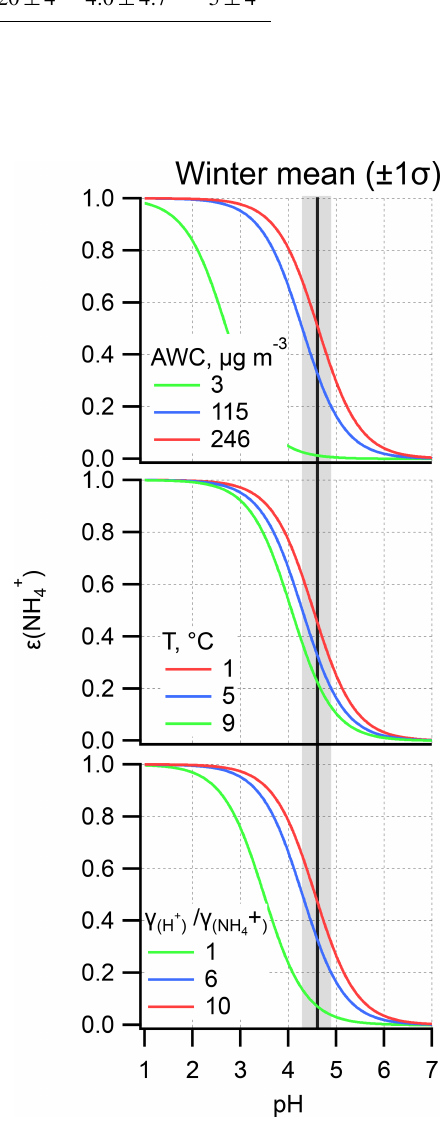
Figure 8. ε (NH + ) as a function of pH during the winter haze pe- 4 riod. Other variables are held constant at the mean value during the winter haze period, while varying only the AWC, T , and activity γ H + coefficients ratio of . Shaded dark areas indicate the winter γ NH + 4 haze mean pH together with 1 standard deviation ( ± 1 σ ). The areas between the green and red line represent the curve corresponding to mean ± 1 σ – note that for AWC mean – 1 σ yields a negative value; thus the minimum mass concentration (3µgm − 3 ) was